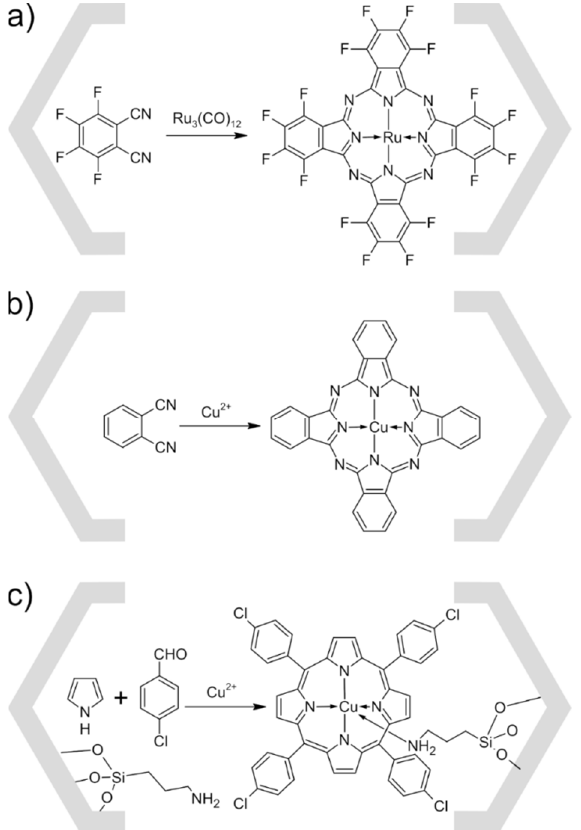
Figure 3. “Ship-in-a-bottle” method of synthesis macrocycles inside mesopores: ( a ) perfluorinated ruthenium(II) phthalocyanine [37], ( b ) copper(II) phthalocyanine [43] and ( c ) copper(II) 5,10,15,20-